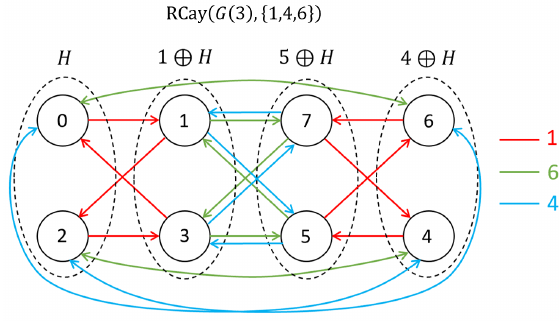
Figure 3. The right-Cayley graph R-Cay ( G ( 3 ) , { 1,4,6 } )